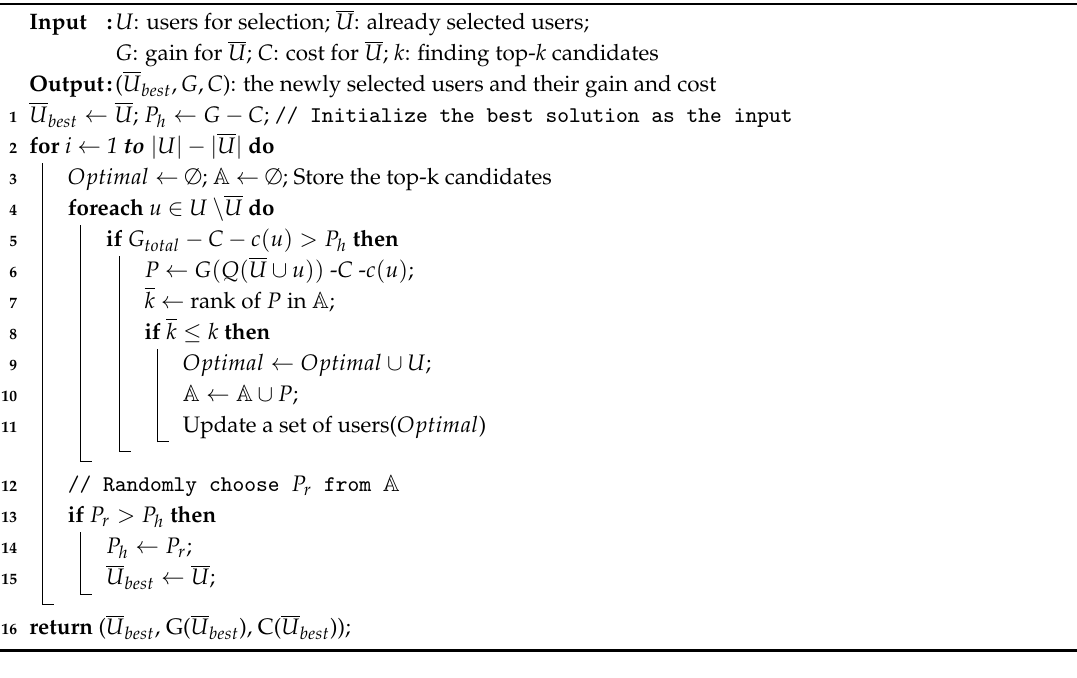
Algorithm 2: Procedure BuildSolution( U , U , G , C , k ).